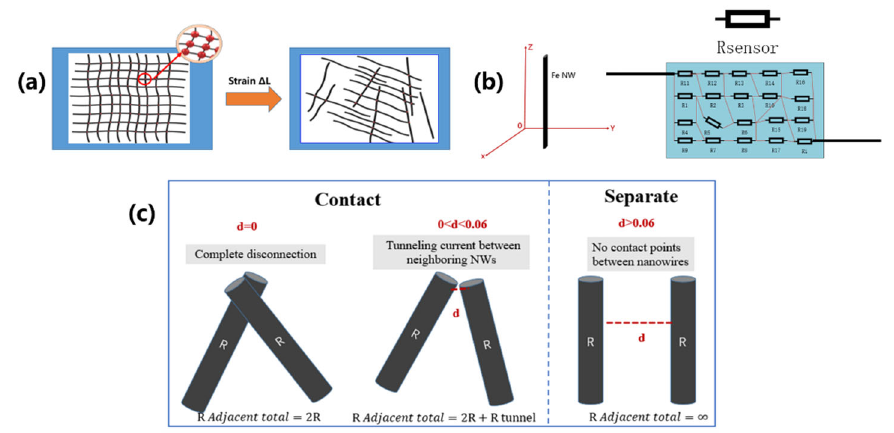
Figure 7. Analysis of the microscopic mechanism of the sensor: ( a ) with stretching, the contact points of the nanowire network are distributed, ( b ) sensor output resistance state model, and ( c ) the relationship between the nanowires inside the sensor.